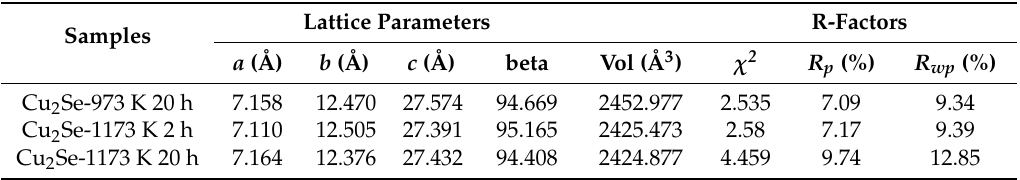
Figure 2. Rietveld refinement of XRD profiles of samples sintered at 973 K for 20 h and 1173 K for 2 h and 20 h. Table 1. The results of the Rietveld analysis of samples.